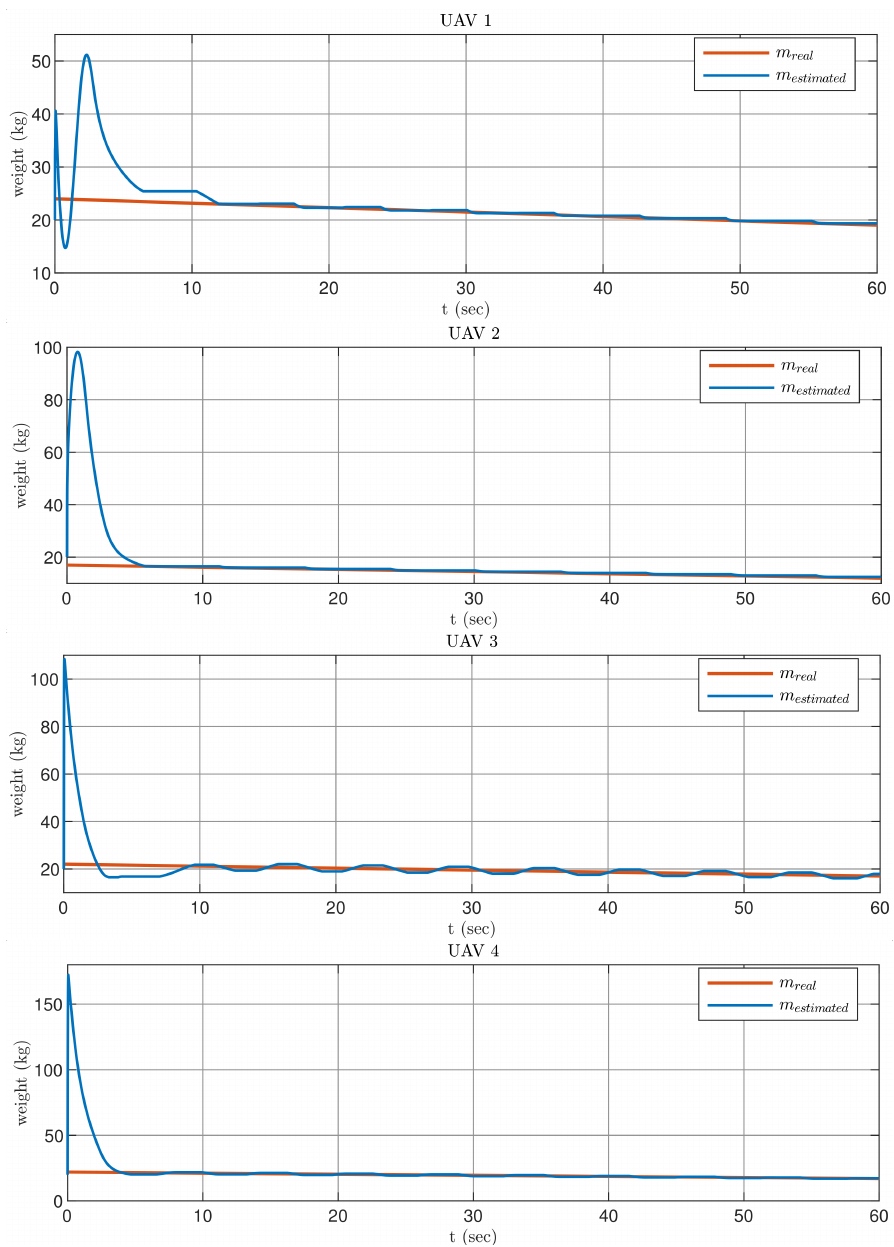
Figure 12. Estimated masses of UAVs in